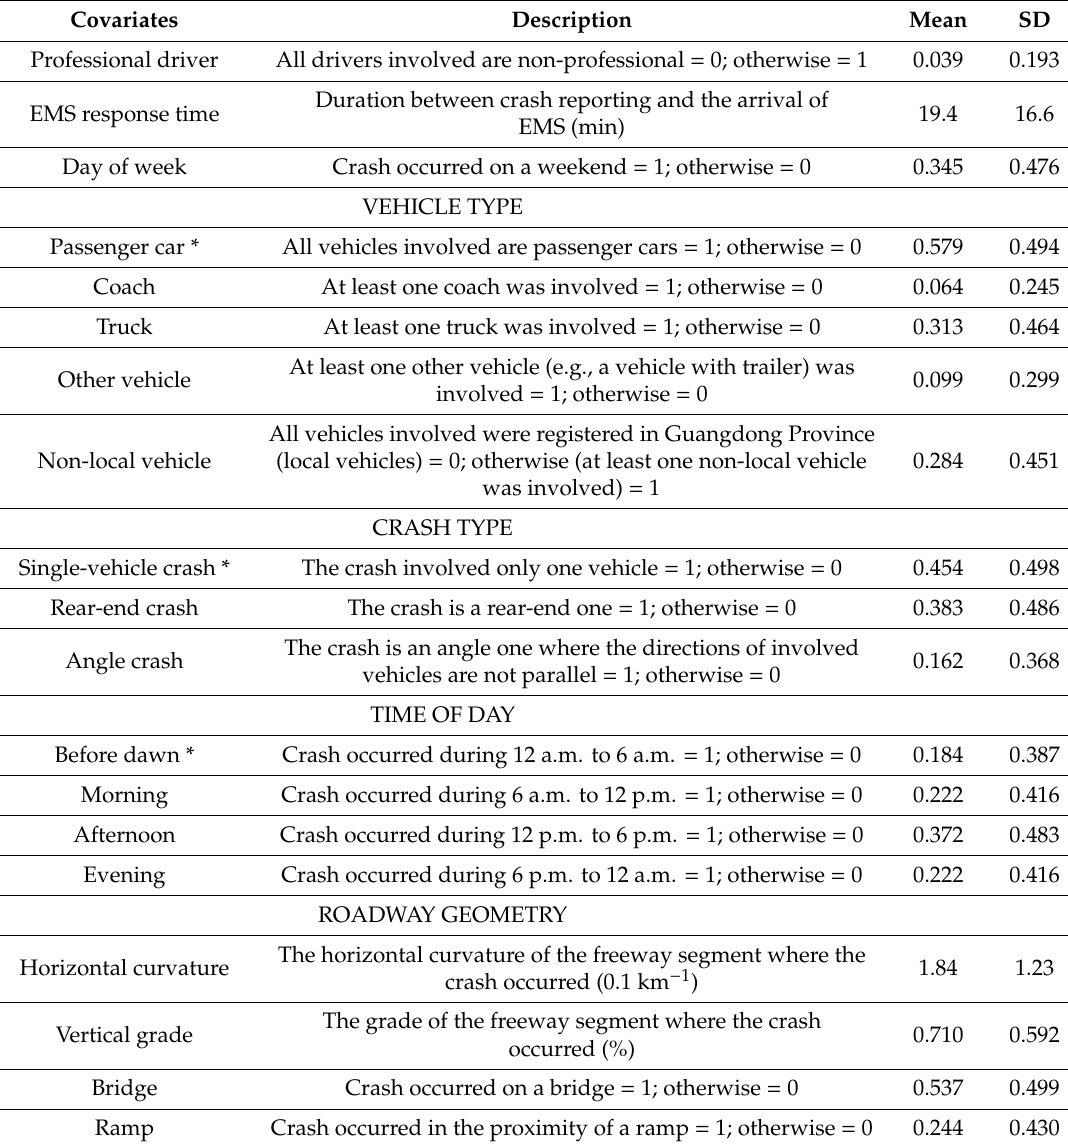
Table 1. Descriptive statistics of explanatory variables for analyzing freeway crash